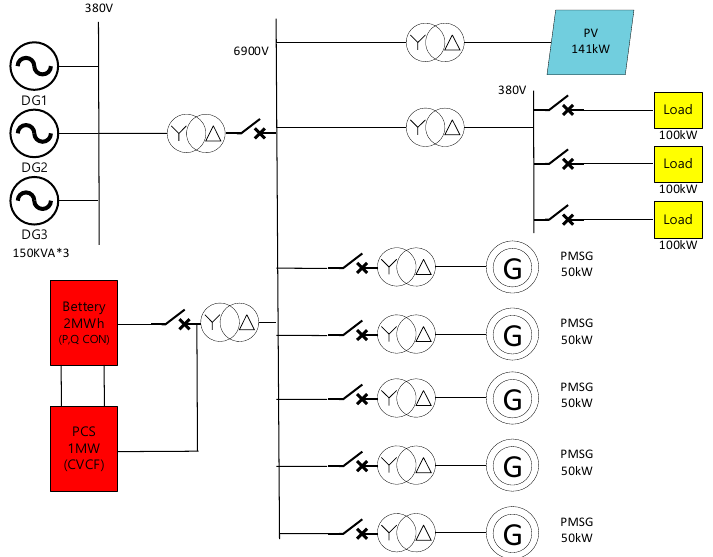
Figure 2. The Proposed Gapado Island Power Grid .